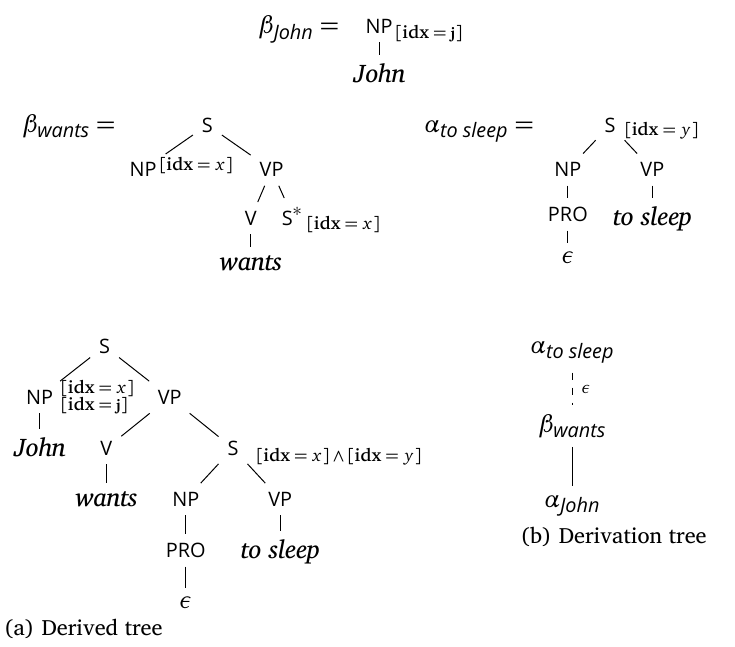
Figure 27: Elementary trees for control verbs